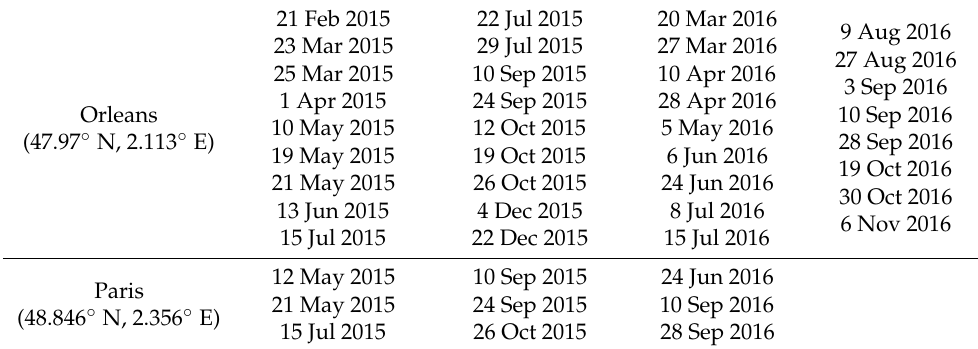
Table A2. Summary of the available dates of different sites used for correlation